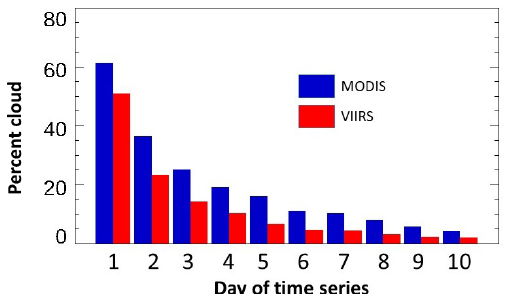
Figure 3. Percent cloud cover in a Terra MODIS (MOD10A1F) and an S-NPP VIIRS (VNP10A1F) time series of snow-cover maps for the western US study area (see location in Fig. 1). Note that the per- centage of cloud cover decreases dramatically in the first few days following the 4 February 2012 initiation of the CGF time series, denoted here as “Day